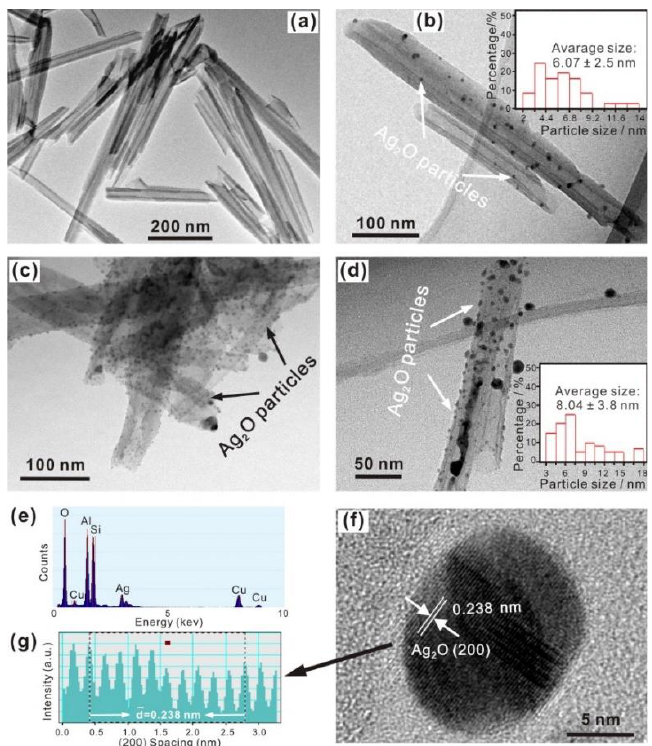
Figure 2. TEM images of ( a ) Hal, ( b ) Hal/Ag 2 O-1 (inset is the histogram of Ag 2 O particle sizes), ( c , d ) Hal/Ag 2 O-2 (inset of Figure 2d is the histogram of Ag 2 O particle sizes), an ( e ) EDS spectrum of Hal/Ag 2 O-2, ( f ) HR-TEM image of a Ag 2 O nanoparticle and ( g ) its integrated pixel